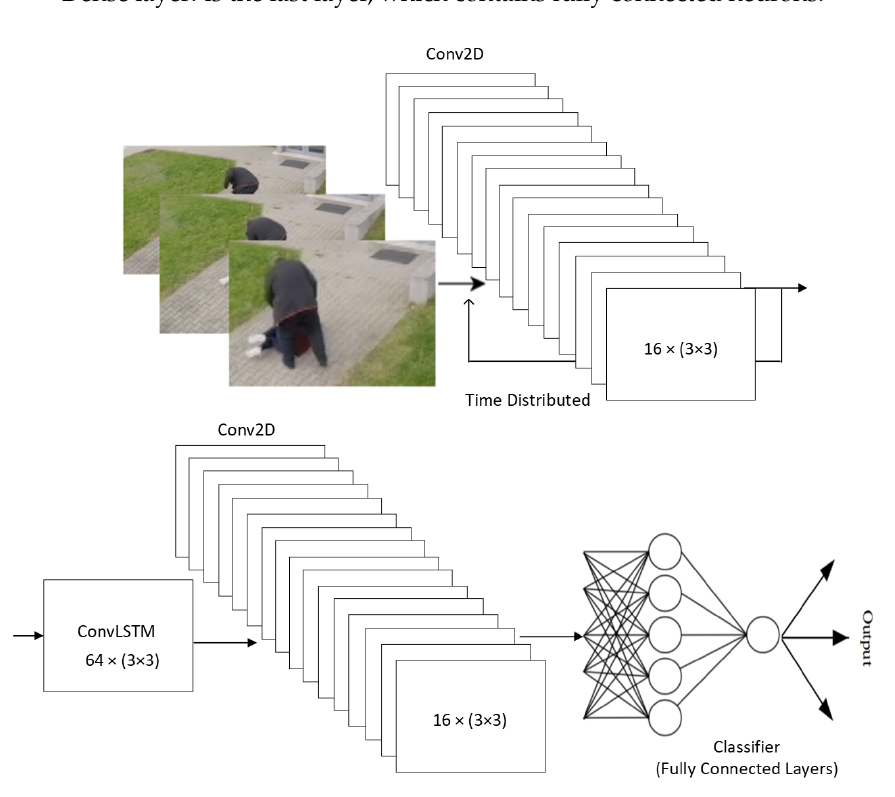
Figure 4. The proposed architecture of